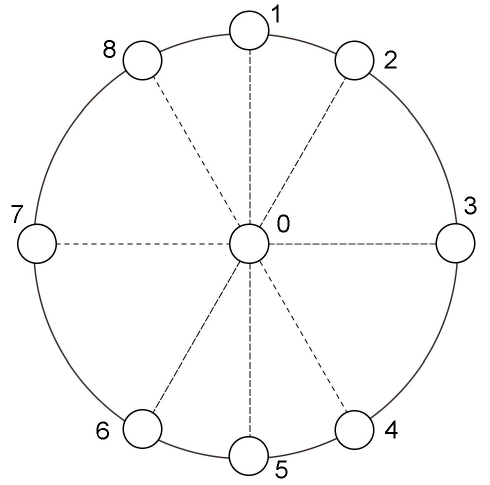
Figure 6. Microphone arrangement.